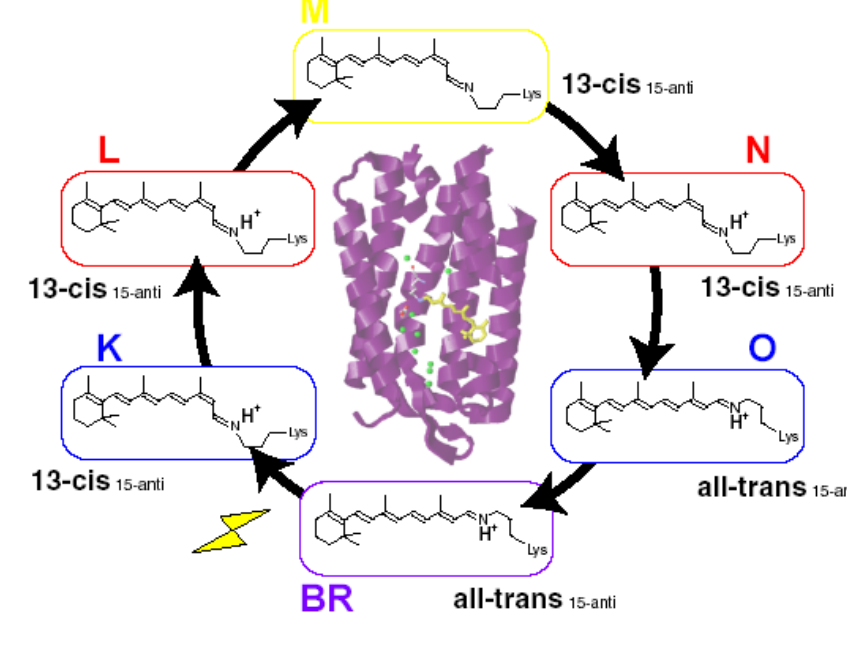
Figure 1. The bacteriorhodopsin photocycle (PDB code: 1C3W) [7]. The reaction starts with light and returns to the initial state through the various intermediates within 10